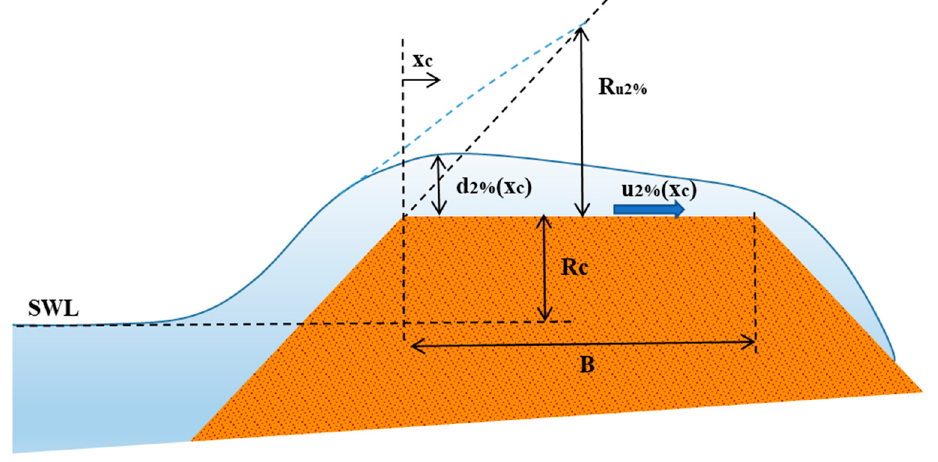
Figure 1. Scheme of overtopping flow on a sea dike.